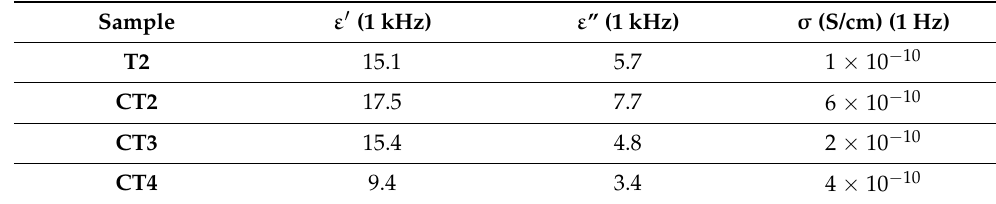
Figure 12. The evolution of conductivity as a function of temperature: ( a ) exemplarily for CT4 at various frequencies and ( b ) comparatively for all examined samples at room temperature. Table 5. Numerical values of dielectric constant, dielectric loss and conductivity were retrieved at room temperature for all examined samples.